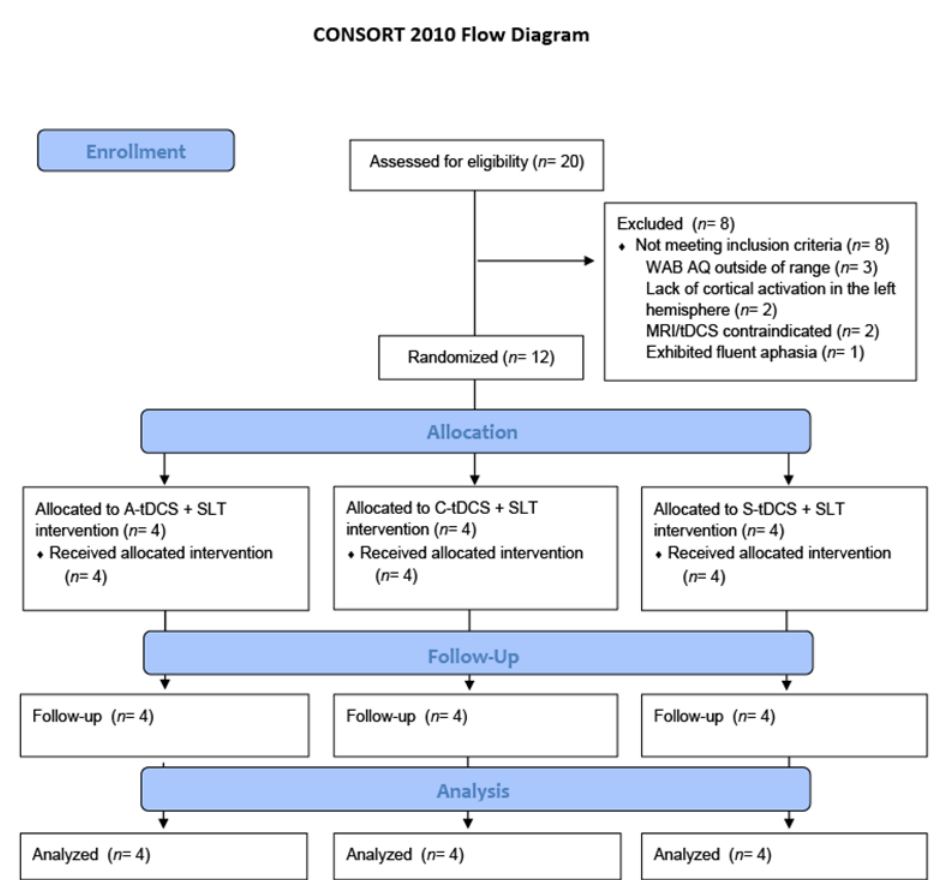
Figure 6. CONSORT 2010 Flow Diagram. Note. A-tDCS = anodal, C-tDCS = cathodal, and S-tDCS = sham stimulation. WAB-R AQ = Western Aphasia Battery-Revised Aphasia Quotient.